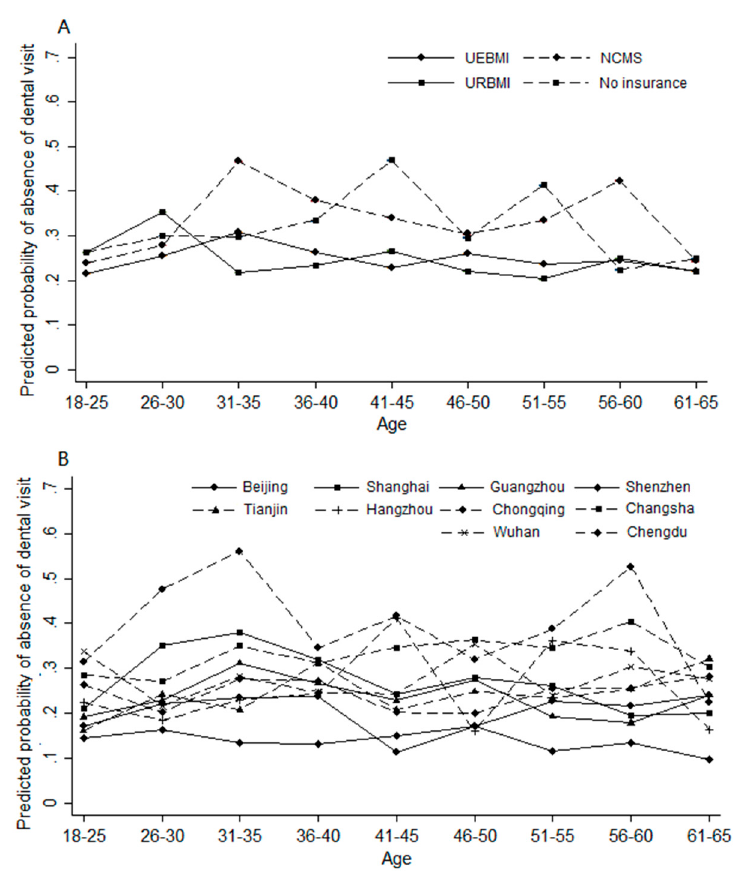
Figure 1. Disparities in predicted probability of absence of dental visit over age (weighted). ( A ) Predicted probability of absence of dental visit over age by health insurance with 95% Cls. ( B ) Predicted probability of absence of dental visit over age by city of residence with 95% Cls. Notes: absence of dental visit indicates having never visited a dentist; all estimations include gender, age, marital status, education years, income, self-rated health, regular physical exam, care about healthy food, self-rated oral health, tooth loss, and gum bleeding as covariates.